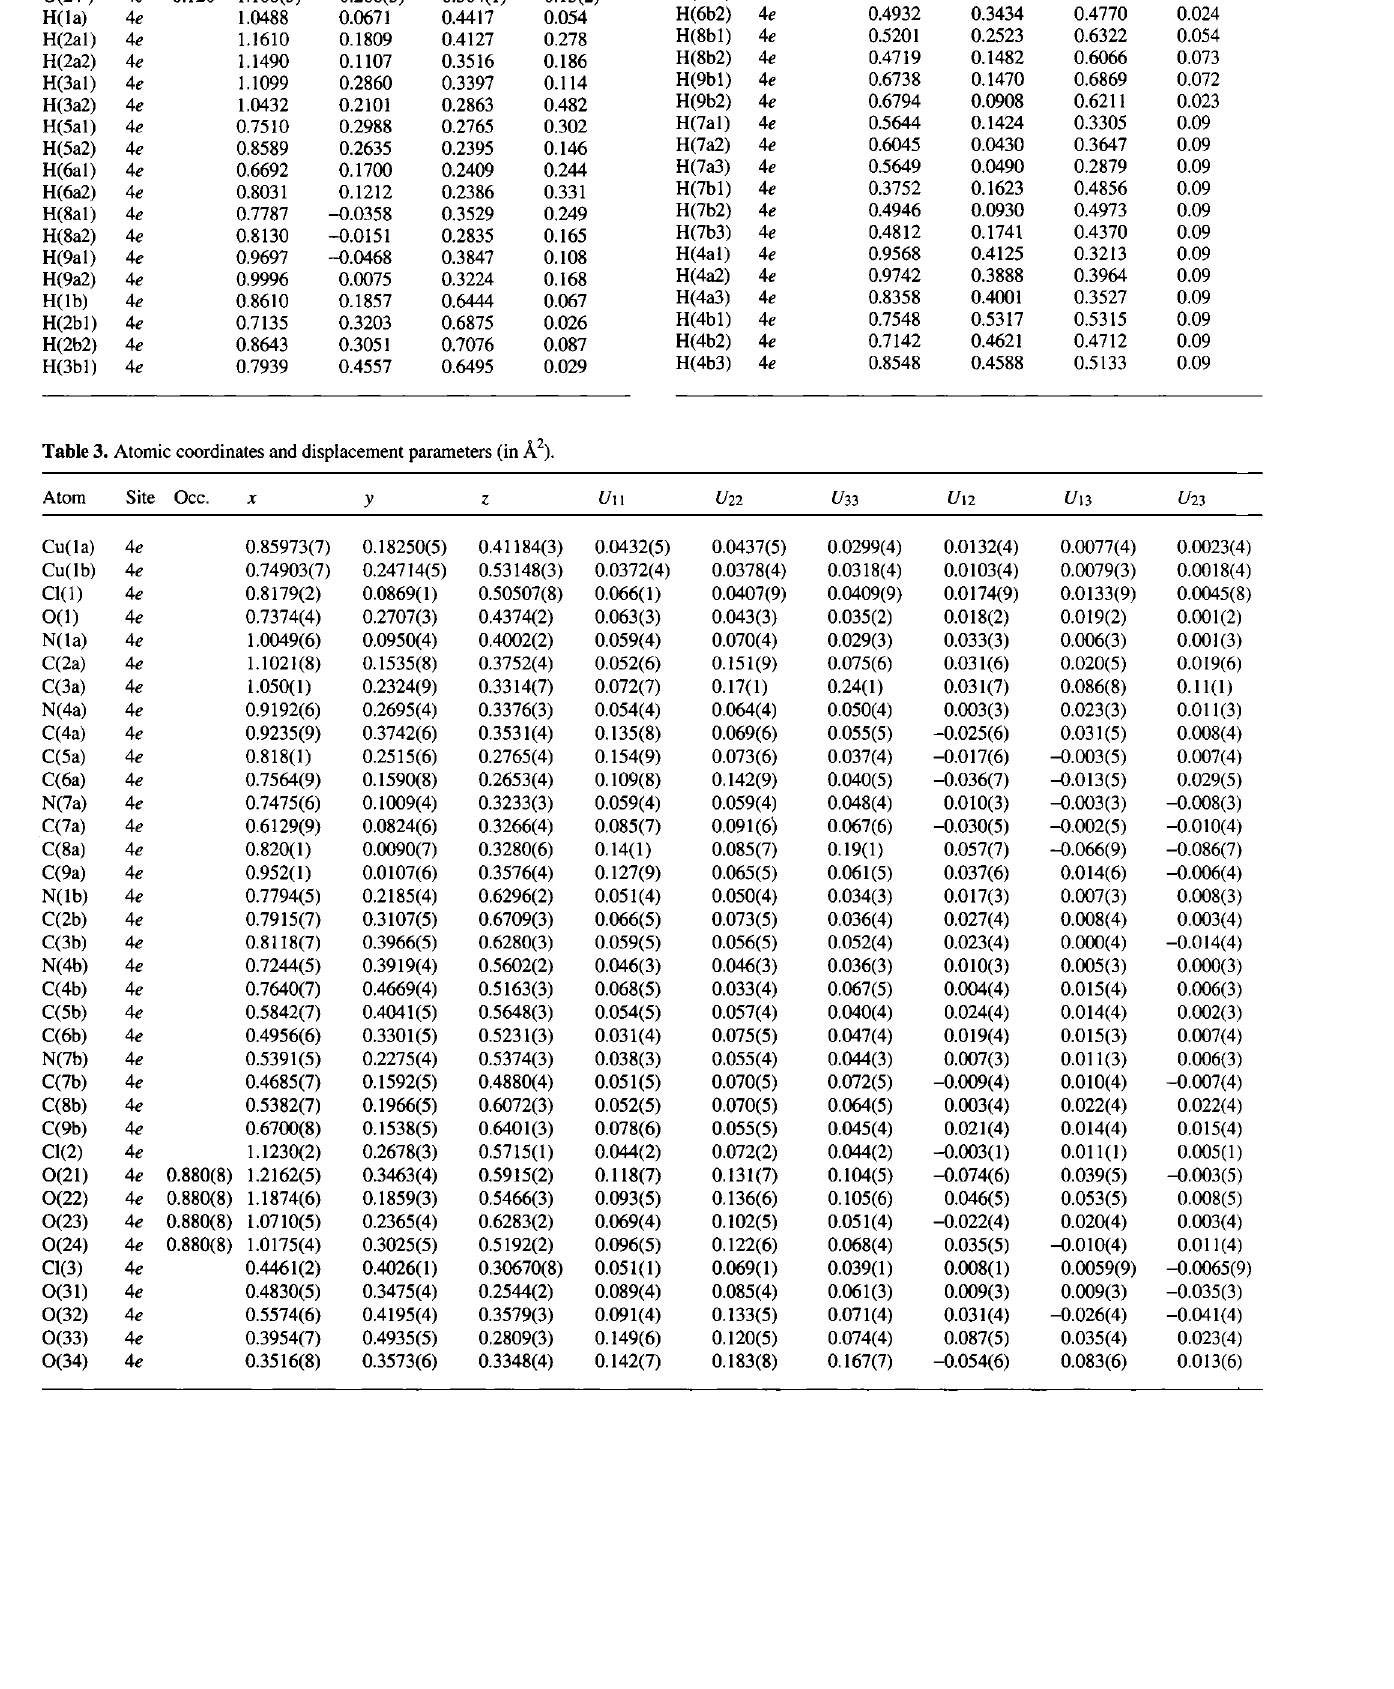
Table 3. Atomic coordinates and displacement parameters (in Â 2